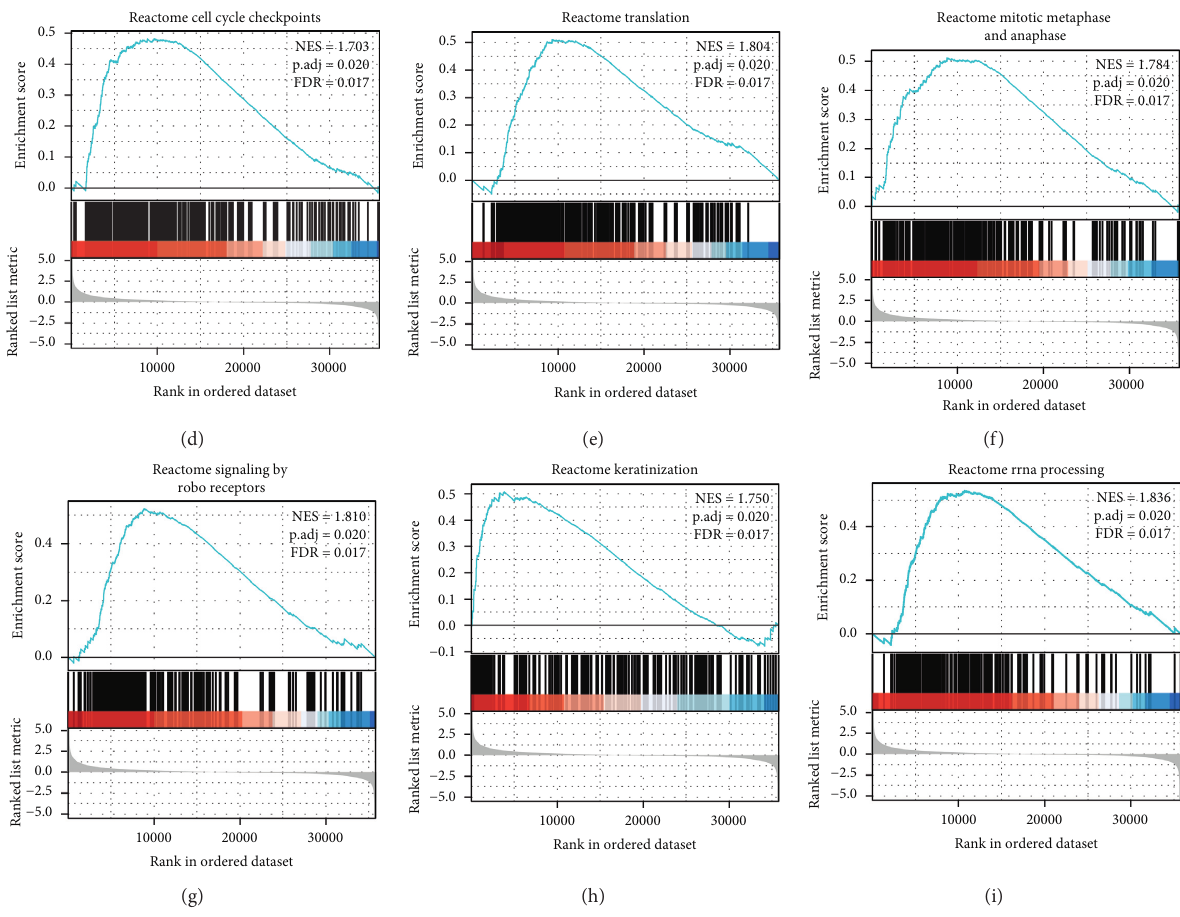
Figure 4: GSEA of ELF3-AS1 in HCC. (a) GPCR-radioligand binding, (b) M phase, (c) Class A/1 (rhodopsin-like receptors), (d) cell cycle checkpoints, (e) translation, (f) mitotic metaphase and anaphase, (g) signaling by robo receptors, (h) keratinization, and (i) rRNA processing were enriched in ELF3-AS1-related HCC. NES, normalized ES; FDR, false discovery rate.